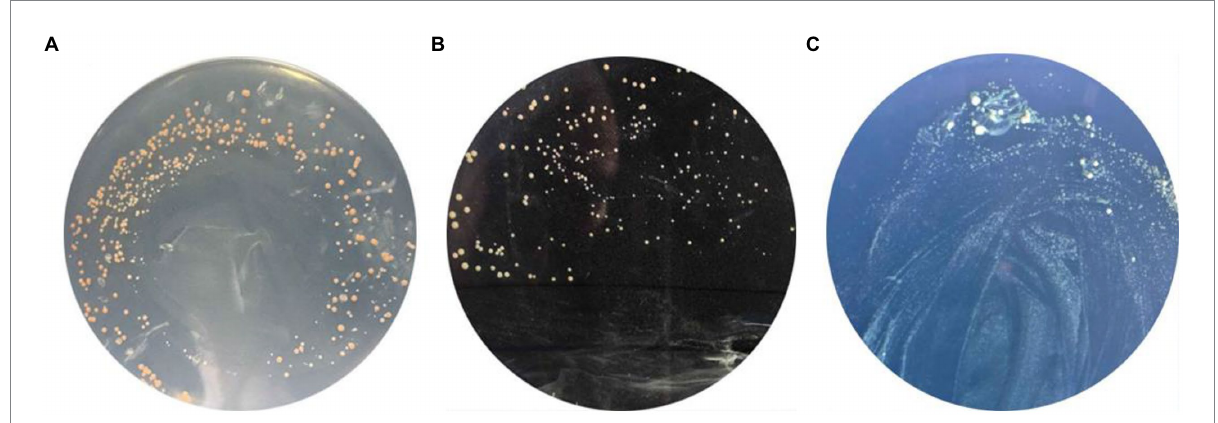
FIGURE 3 Yeast two-hybrid assay. Self-activation of recombinant vector pBD- GlnR (A) . The result of empty gsensor conversion of pGBKT7 and pGADT7 (B) . The result of interaction of NiR and GlnR Proteins (C) .